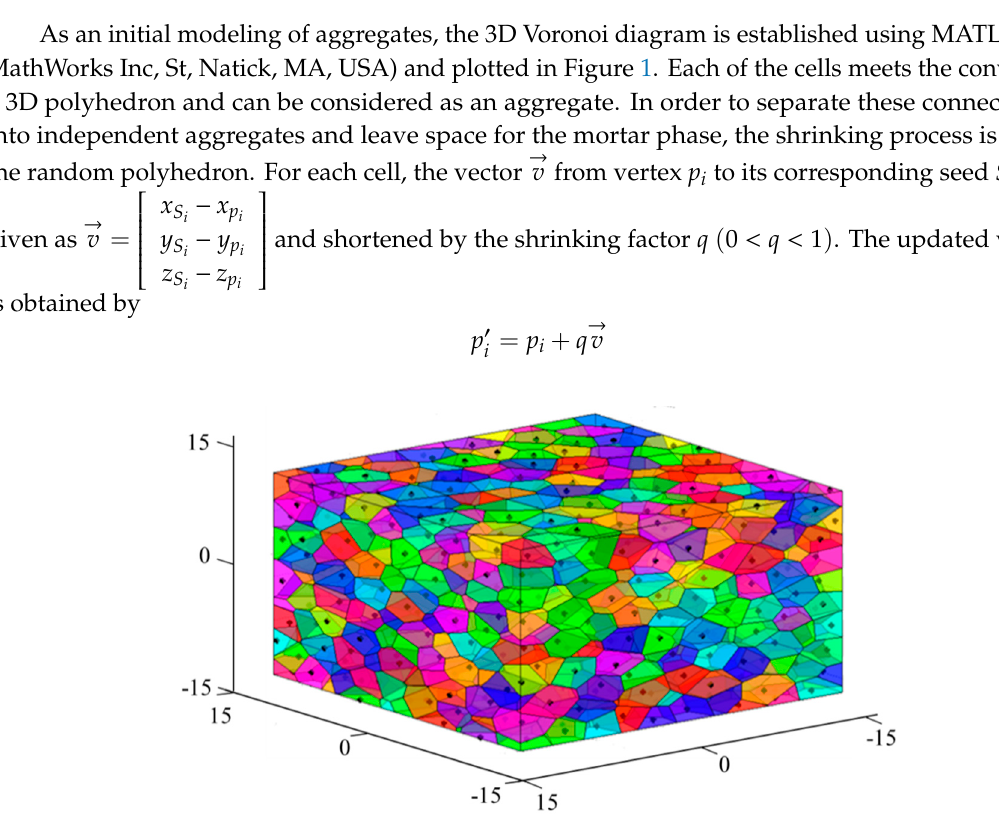
Figure 1. Resulting 3D Voronoi polyhedrons when K = 0.2.